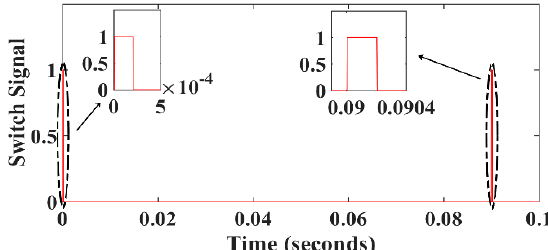
Figure 13. Activated switch signal.